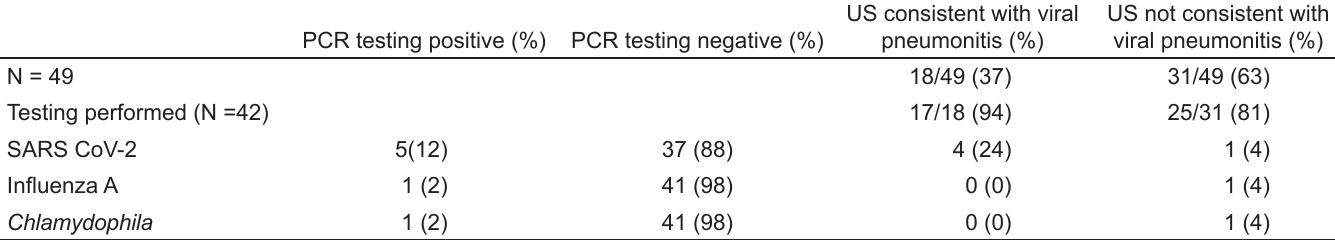
Table 4. PCR results from nasal, nasopharyngeal, and oropharyngeal swabs, and lung ultrasound results. Although the overall number of polymerase chain reaction tests was the same, some patients received SARS-CoV-2 testing alone, while others had a panel of respiratory pathogens ordered without SARS-CoV-2 due to lack of test availability at the time. The panel of respiratory pathogens tested included adenovirus, parainfluenza viruses 1-4, Mycoplasma pneumoniae , Bordetella pertussis , coronaviruses 229E, HKU1, N163 and OC43; respiratory syncytial virus; human metapneumovirus; Chlamydophila ; and Chlamydophila pneumoniae